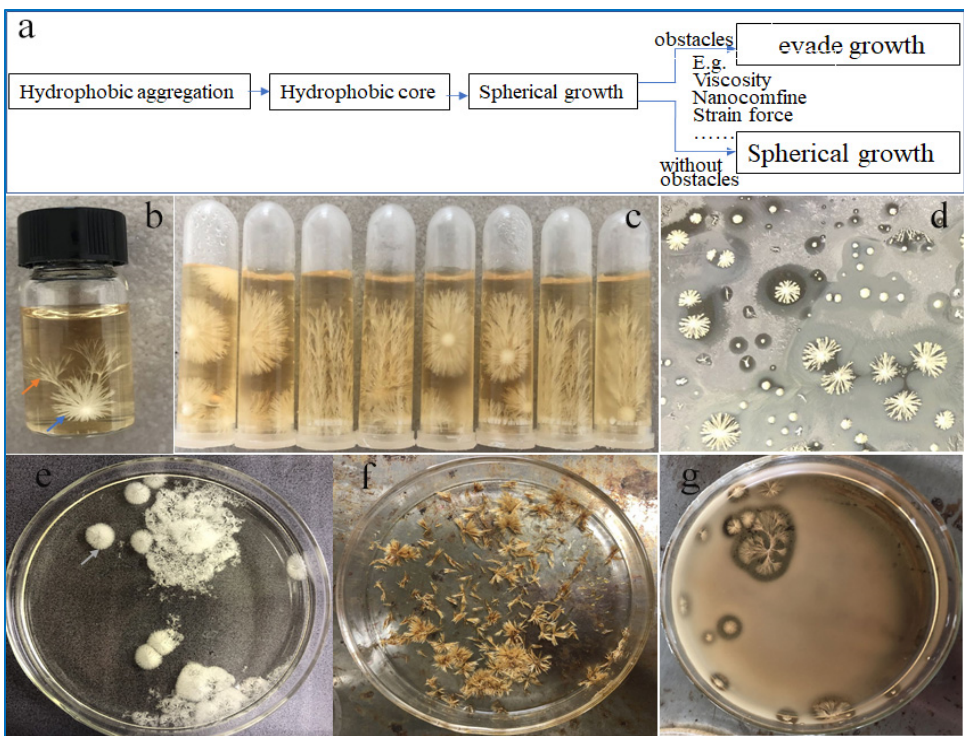
Figure 4. EVA in CMCS sol. ( a ) growth pattern of EVA crystal in CMCS gels, ( b ) Free spherical growth in sol (blue arrow) or tree growth in CMCS gels (yellow arrow)), ( c ) Hydrophobic aggrega- tion core of EVA in CMCS sol, ( d ) spherical aggregation of CMCS/EVA on silicon wafer surface; ( e ) 2 × 10 3 molecular weight CMCS forms loose velvet flower in CMCS sol (grey arrow); ( f ) dried state of velvet flower, ( g ) 15 × 10 4 molecular weight CMCS forms CMCS/EVA tree crystals in plate. EVA crystallization is accompanied the CMCS gel process, and vice versa, it also quickened the formation of a hydrogen bond network. Therefore, a large number of small space compartments (Figure 6b) formatted with nanoconfinement effect accompanied this process. EVA immediately crystallized within such confinement regions by a local supersaturation effect [50]. EVA can easily fall off from these small compartments in the same way as sand falling, so far as to be visible by a common magnifier. Interestingly, granular crystals were obtained after freeze-drying, while bulk crystals were obtained after acid lysis. This indicates that hydrogen bonds play an important role in the crystal formation of